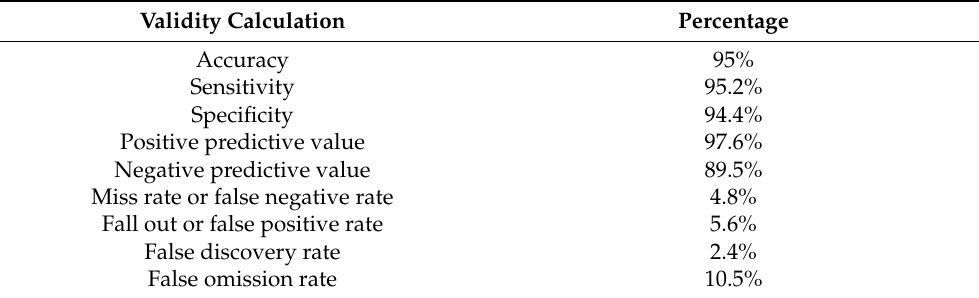
Table 7. Criterion-related validity calculations for the S-SARS model ( n = 60).